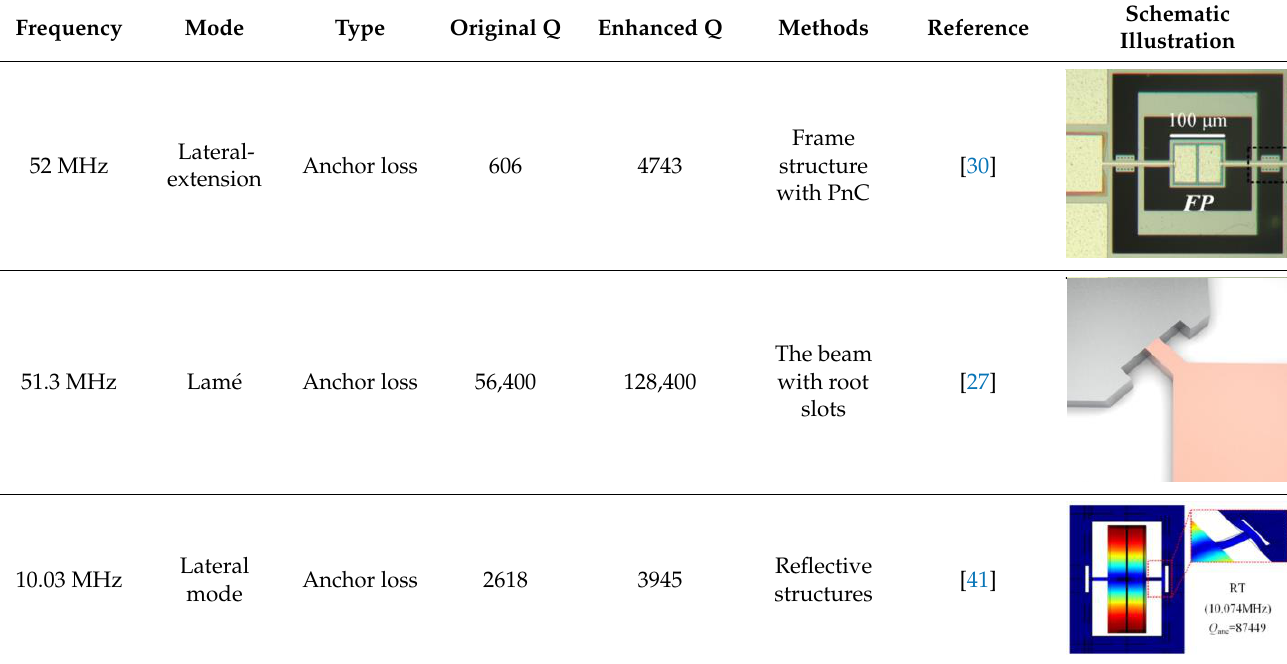
Table 3. Typical methods of improving quality factor.